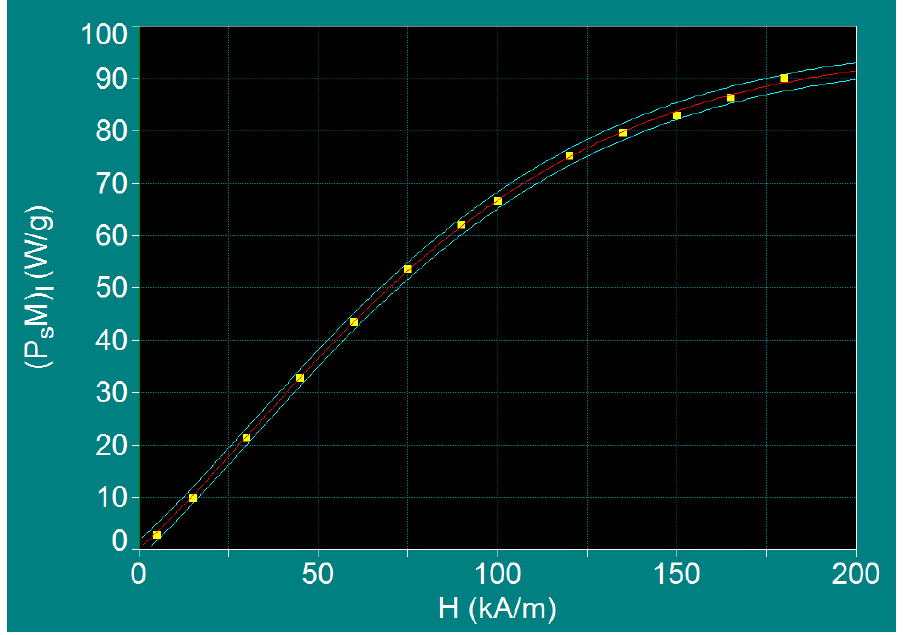
Figure 8. The variation of maximum specific loss power within the admissible biological limits (P sM ) l as a function of the magnetic field H in the case of CoFe 2 O 4 nanoparticles. While analyzing this dependence, it was observed that, in the case of CoFe 2 O 4 nanoparticles, the maximum specific loss power (P sM ) l increases proportionally with the increase of the magnetic field up to 90–100 kA/m. Above these values, the maximum specific loss power tends towards saturation.